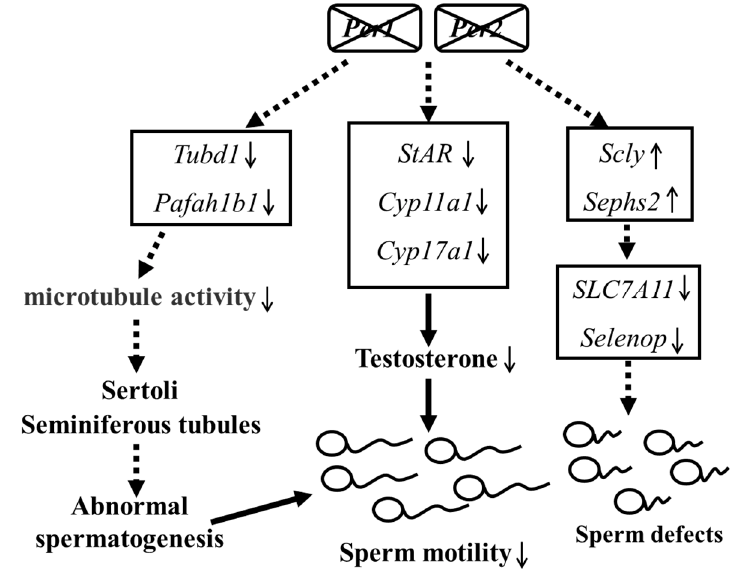
Figure 7. The mechanism by which Per1/Per2 affect steroid hormone synthesis as well as microtubule activity and selenium metabolism.